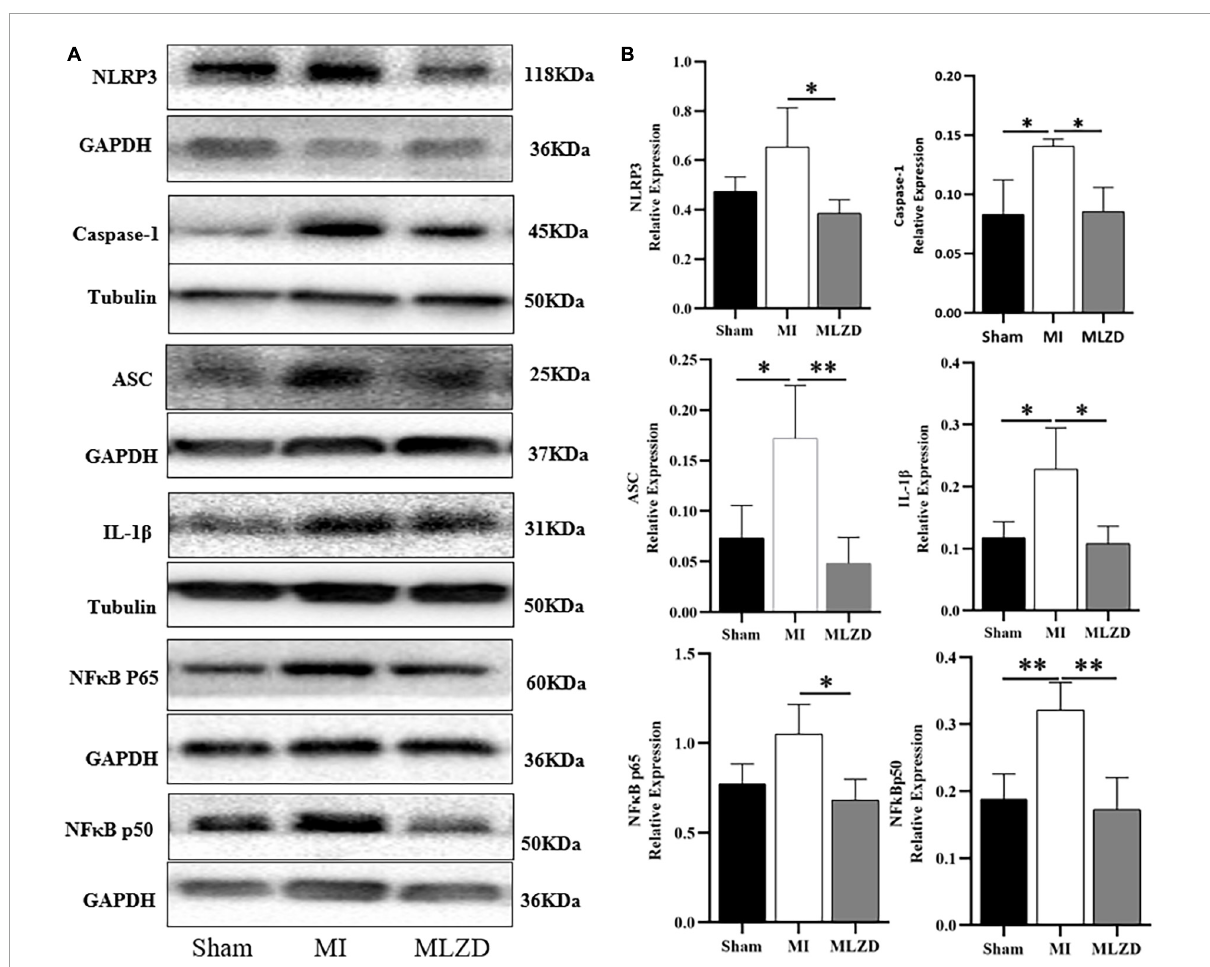
FIGURE5 Modified Linggui Zhugan Decoction (MLZD) inhibits the expression of inflammatory proteins. (A,B) Western blot analyses of the expression of NLRP3, caspase-1, ASC, IL-1 β , NF κ B p65, and NF κ B p50 in cardiac tissue. The widths of the images have been compressed at a ratio of 1:0.6. n = 3 or 4 per group. Data are represented as mean ± standard deviation ( x ± s); ∗ P < 0.05, ∗∗ P <